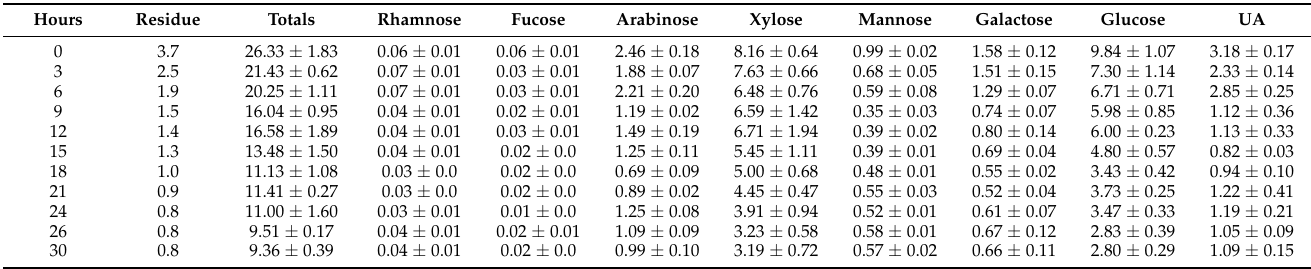
Table 2. Cell wall insoluble monosaccharide composition a